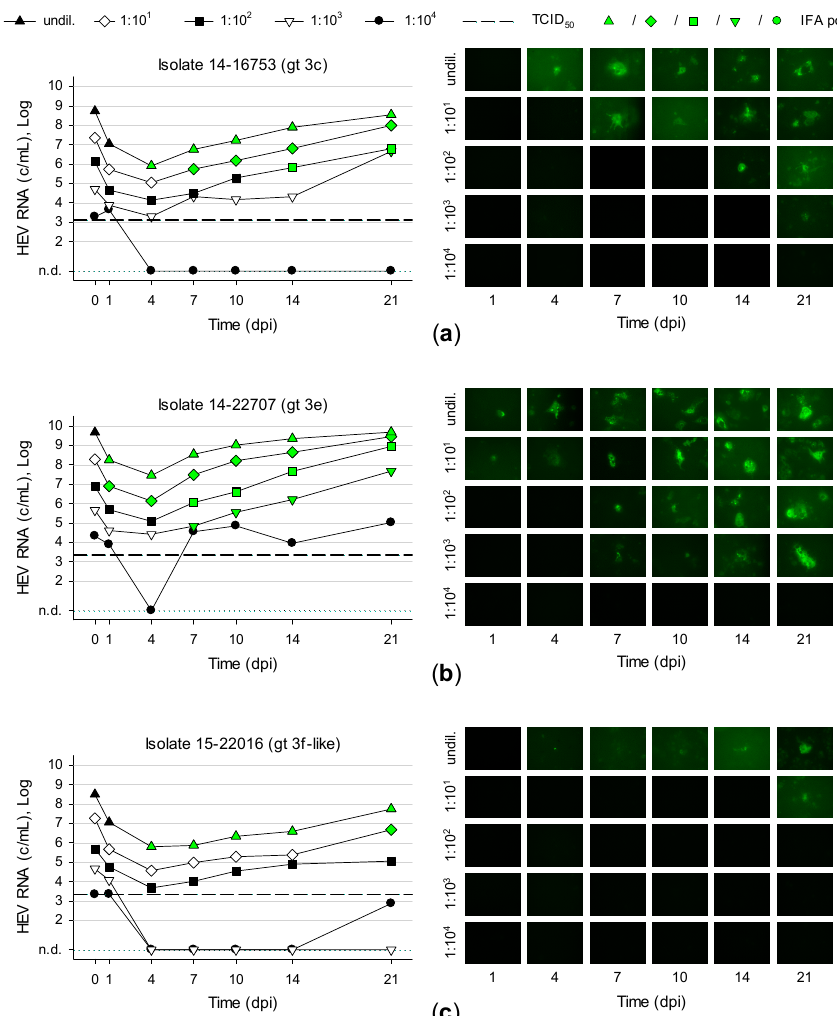
Figure 5. Titration and replication kinetics of novel isolates. PLC / PRF / 5 were inoculated with serial tenfold dilutions of first passage isolates ( a ) 14-16753, ( b ) 14-22707 and ( c ) 15-22016. After 1, 4, 7, 10 14 and 21 days post inoculation (dpi) supernatants were tested for HEV RNA (left panels) and cells were indirectly stained for HEV capsid antigen by immunofluorescence assay (IFA; right panels). Dashed lines represent the respective TCID 50 values determined in a separate experiment. N.d., not detected, undil., undiluted.